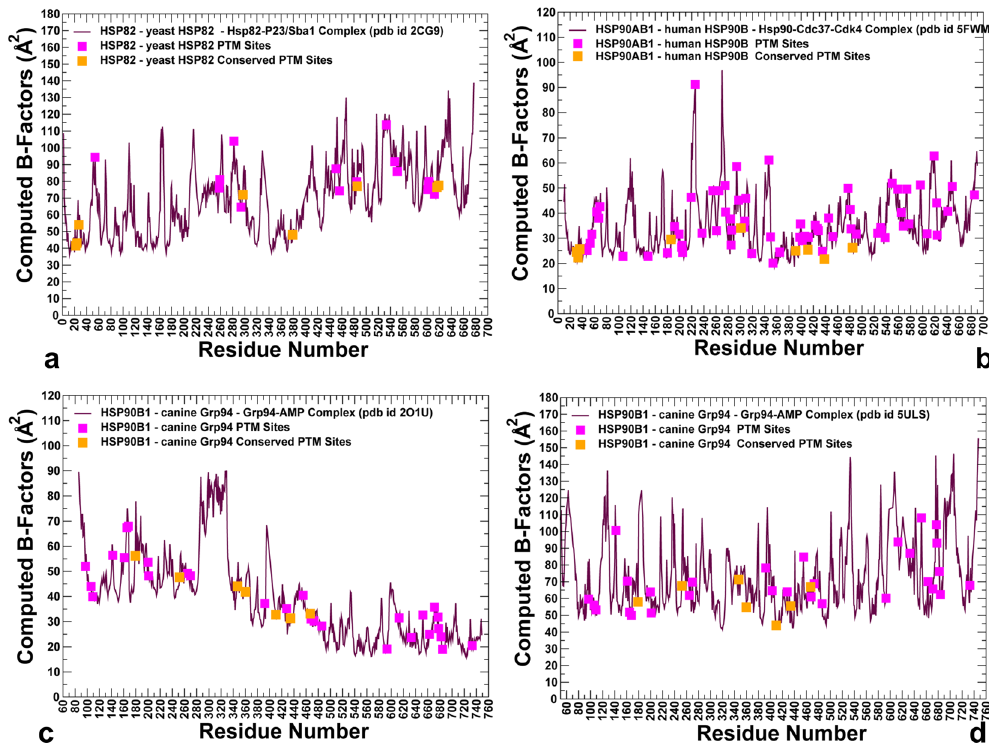
Figure 4. Conformational Dynamics Profiles of the Hsp90 Proteins from Atomistic MD Simulations. Conformational dynamics profiles obtained from all-atom MD simulations of the yeast Hsp82 ( a ), human Hsp90 β ( b ), and canine Grp94 ( c , d ). Residue-based conformational mobility profiles are represented by computed B-factors for protein residues. The mobility values of PTM sites along profiles are depicted in filled magenta squares and evolutionary conserved PTM sites are highlighted in filled orange